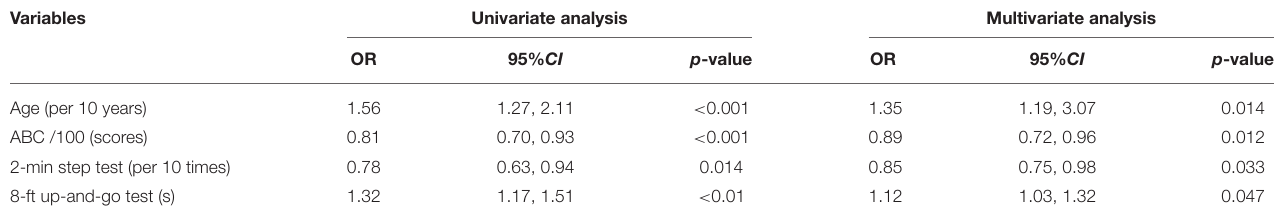
TABLE 4 | Logistic regression model for risk factors associated with fall. Variables